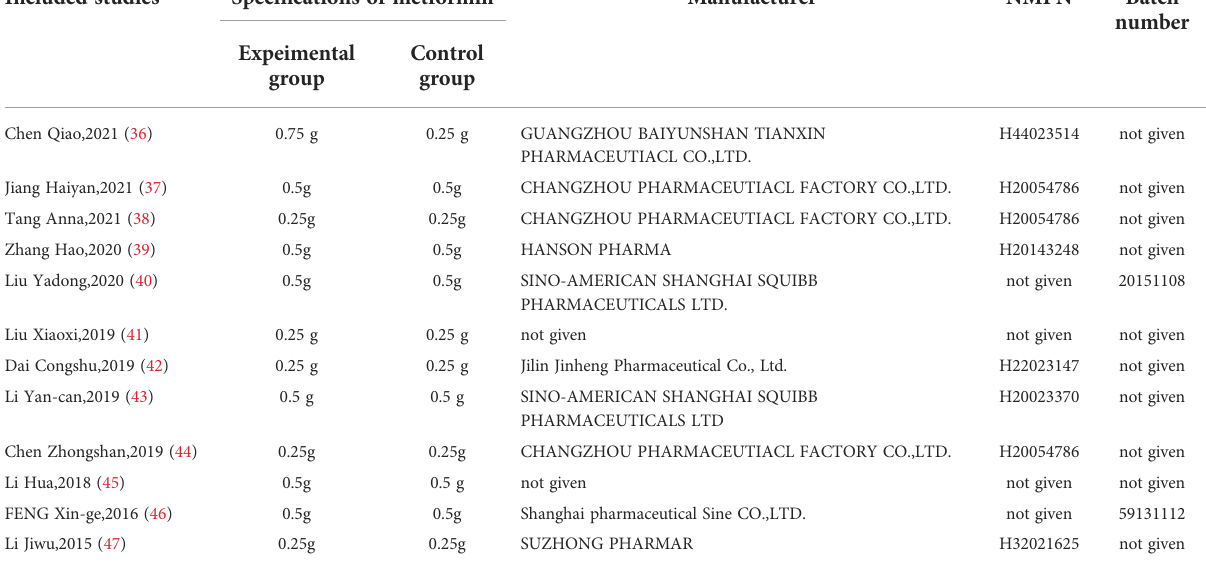
TABLE 2 Detailed information on